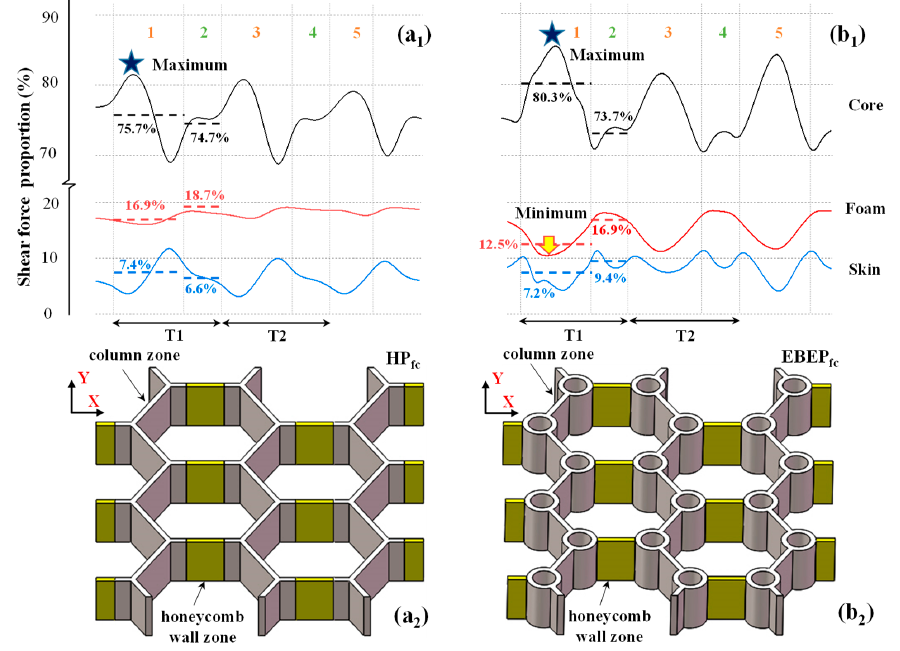
Figure 7. The core structure in the calculation interval and the FE results of the shear force proportions of the BFRP core skeleton, foam and skin of the two sandwich plates: ( a 1 , a 2 ) HP fc and ( b 1 , b 2 ) EBEP fc . The shear force proportion of the skin refers to the ratio of the sum of the shear forces born by the upper and lower skins to the total shear force. The data in the figure are the average values in the calculation intervals. The numbers in ( a 1 , b 1 ) show column zones (orange numbers) and honeycomb wall zones (green numbers).